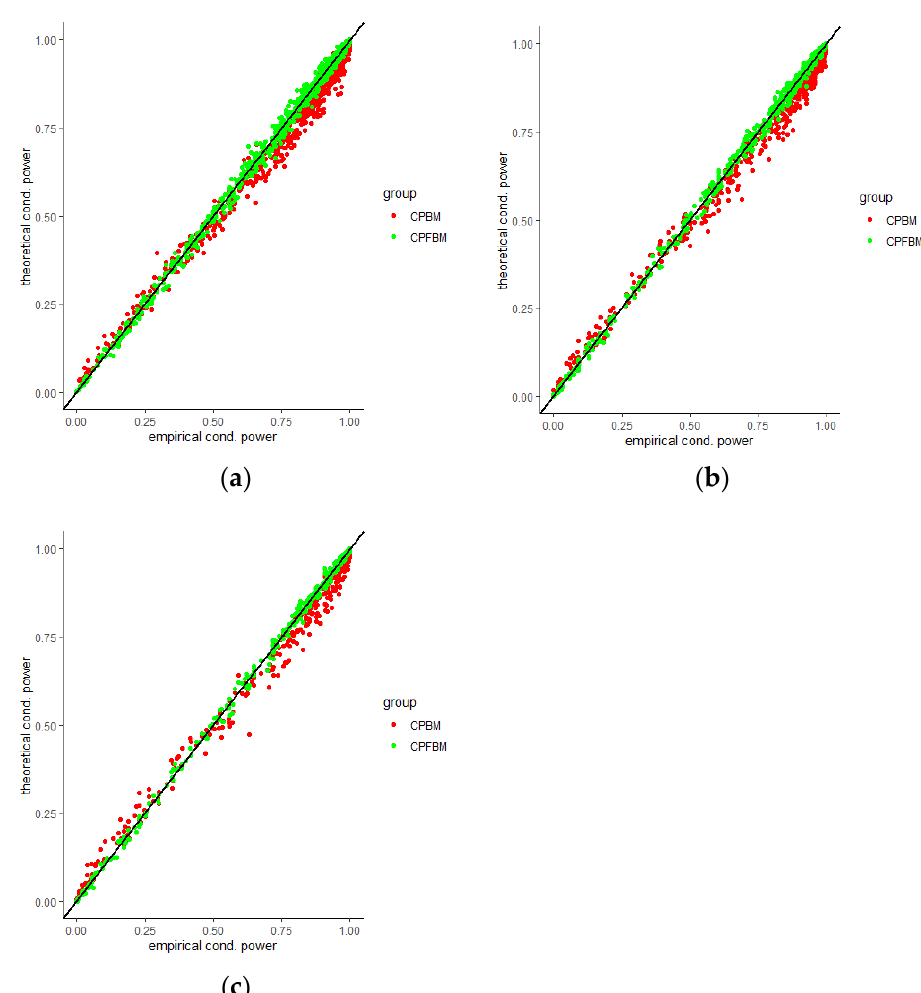
Figure 8. Scatter plots for conditional power under misspecification scenarios (SPB design) showing two discrete covariates with different ti.fix time points: ( a ) ti.fix = 0.7; ( b ) ti.fix = 0.8; ( c ) ti.fix = 0.9.